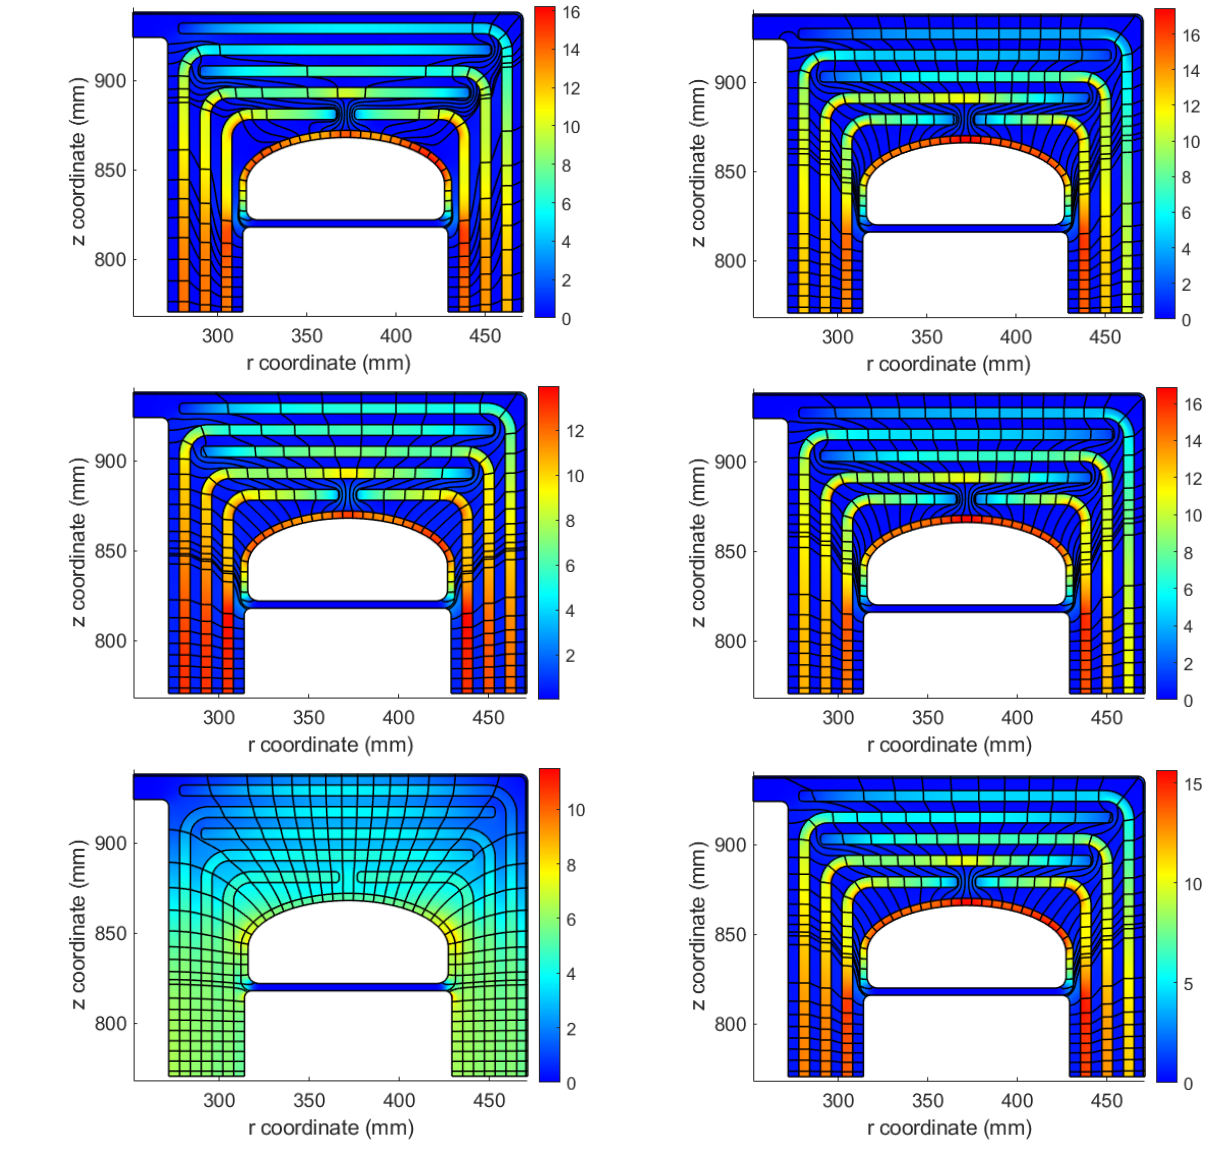
Figure 8. The final steady state stress distribution in kV/mm and the electric field streamlines in the dielectric structure of the MFT at different temperatures using: ( left ) mineral oil; ( right ) ester oil.